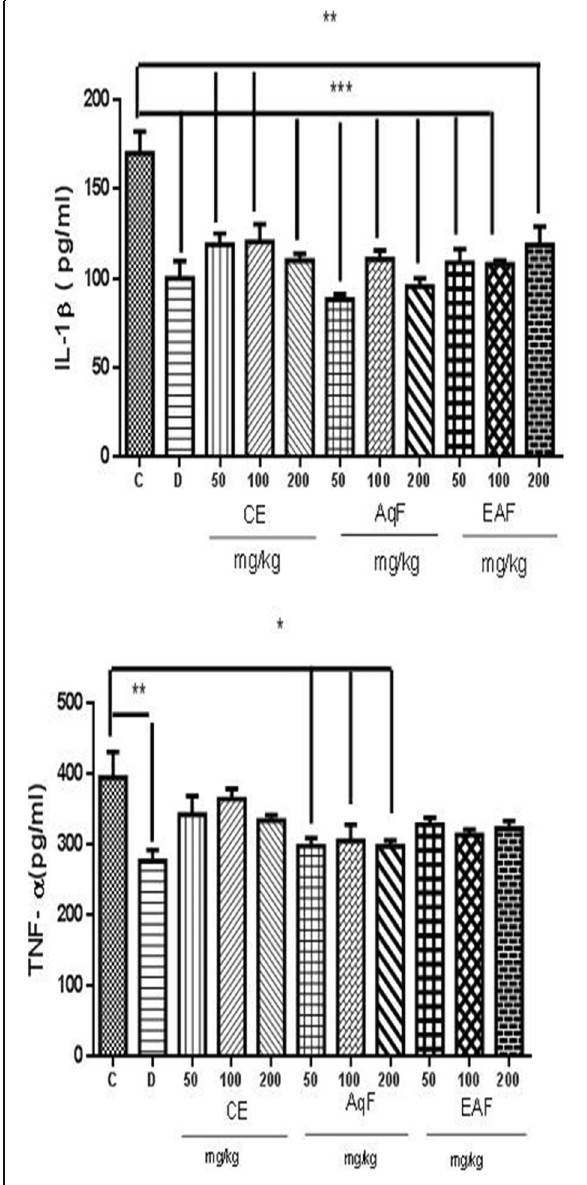
Fig. 6 Levels of inflammatory citokynes IL-1 β and TNF- - α .